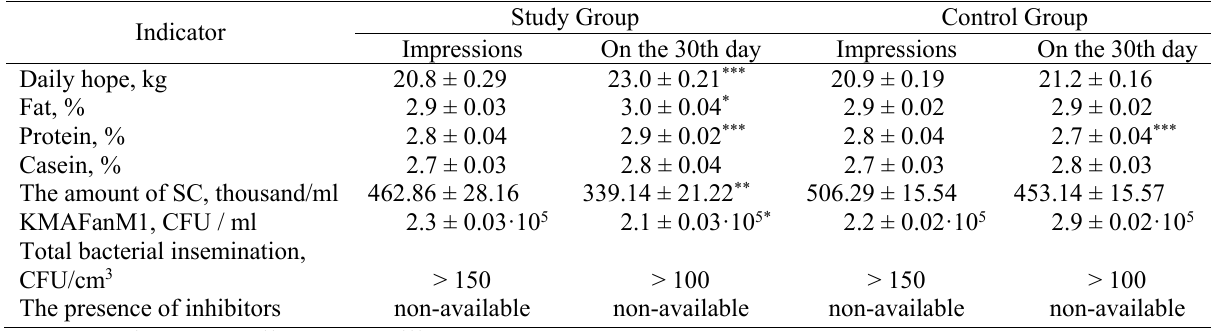
Milk quality indicators, M ± m, n = 7